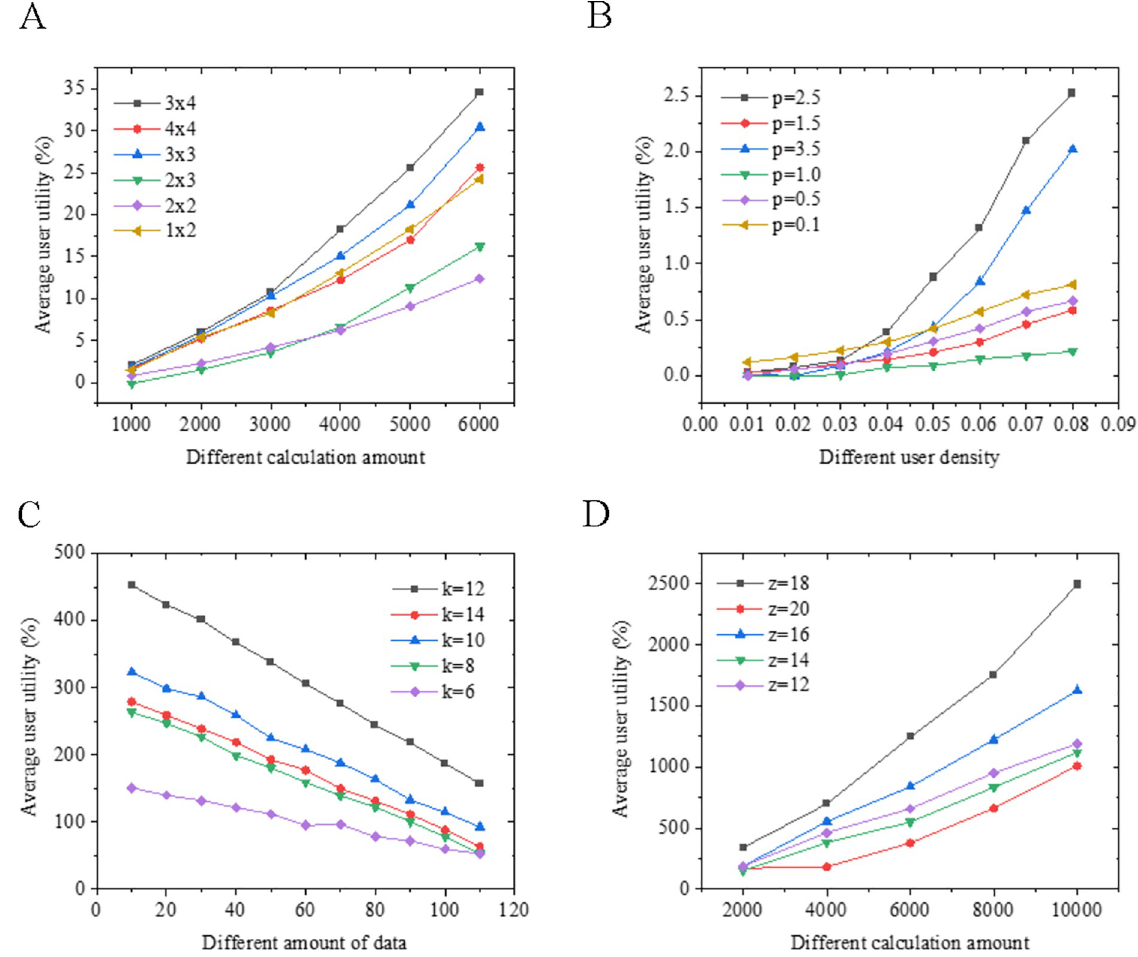
Fig 9. Performance results under different model